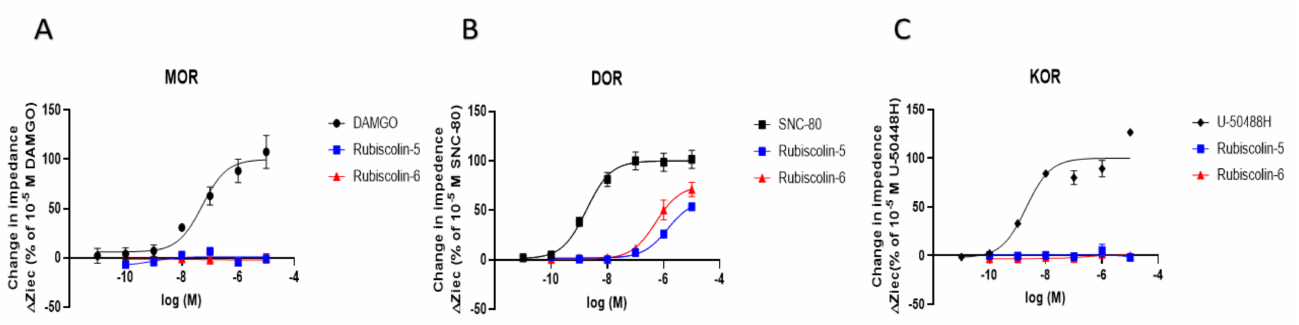
Figure 2. Effect of rubiscolins on MOR, DOR, and KOR, observed using the CellKey TM system. The cells expressing MOR ( A ), DOR ( B ), and KOR ( C ) were treated with each compound (10 − 11 –10 − 5 M), and changes in impedance ( ∆ Ziec) were measured using the CellKey TM system. Concentration–response curves were prepared by calculating ∆ Ziec relative to the data obtained for each positive control: 10 − 5 M DAMGO for MOR ( A ), 10 − 5 M SNC-80 for DOR ( B ), and 10 − 5 M U-50488H for KOR ( C ). All data points are presented as means ± S.E.M. for three independent experiments ( n =